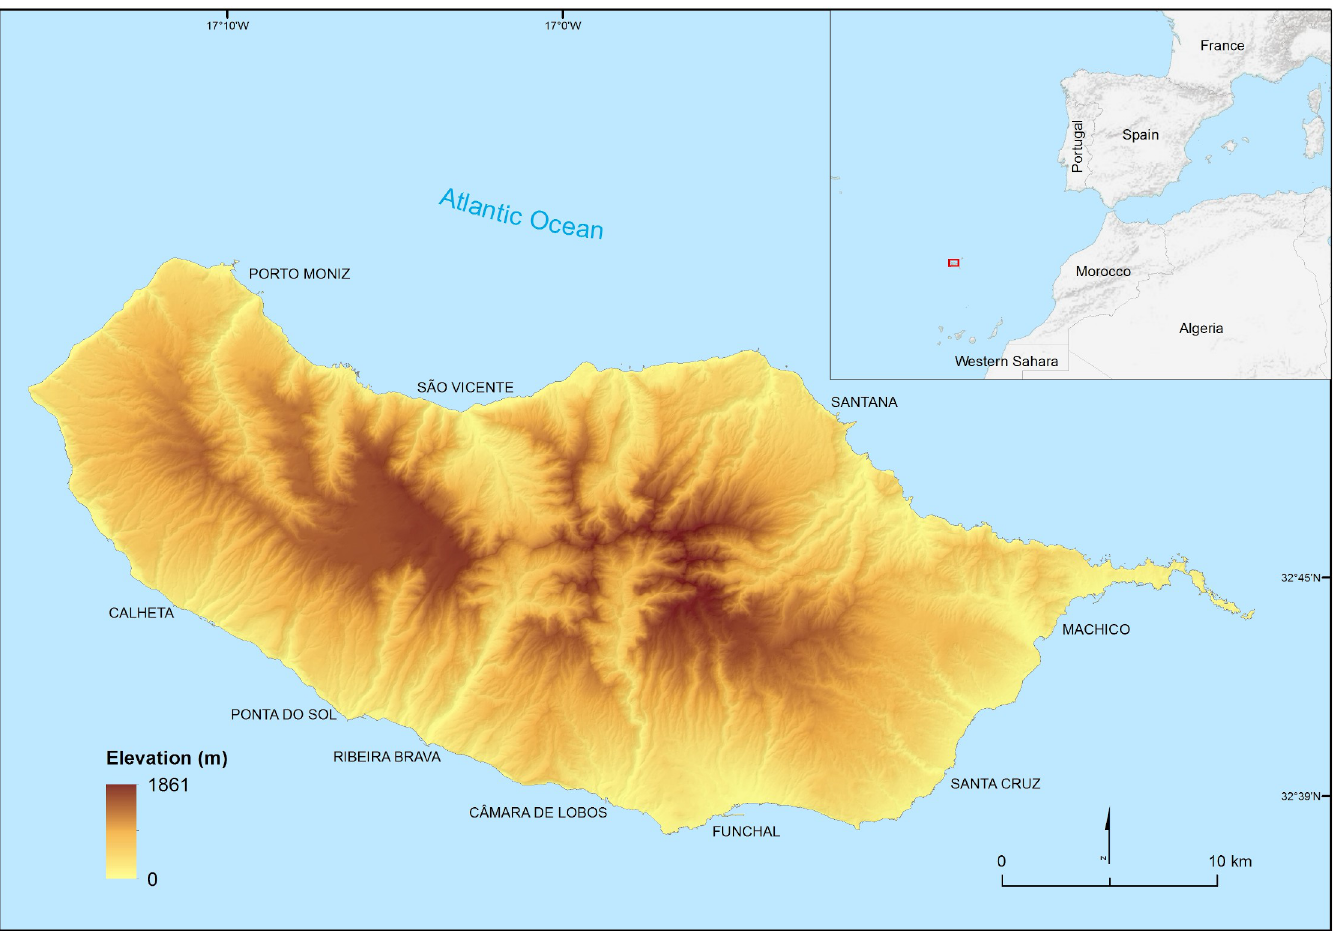
Fig 1. Geographical location and topography of Madeira Island (sources of shapefiles:https://www.dgterritorio.gov.pt/cartografia/cartografia-tematica/caop; and https://gadm.org/download_world.html).